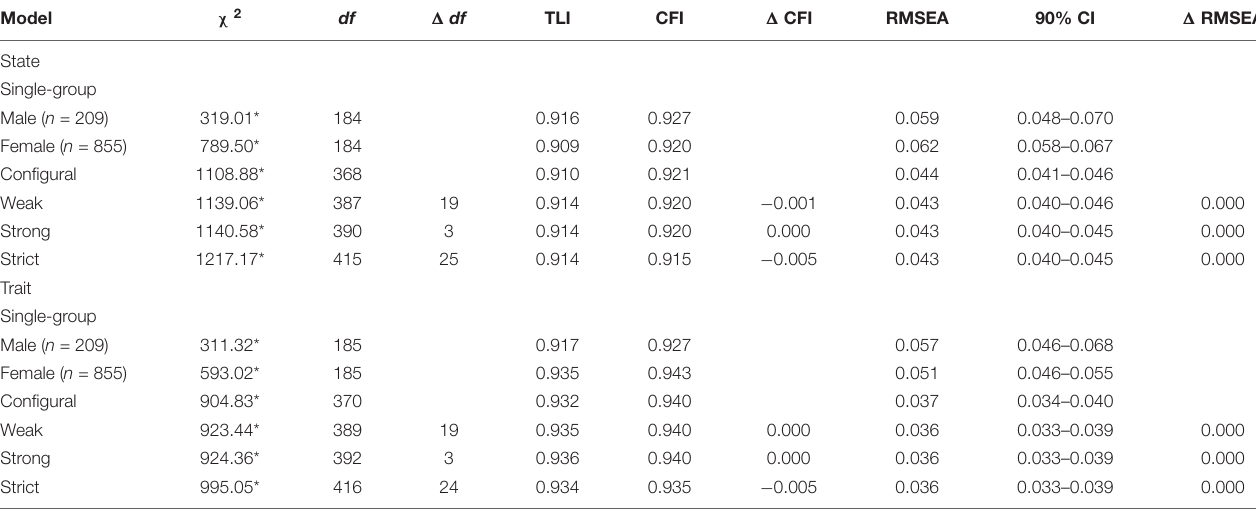
TABLE 3 | Measurement invariance across male and female samples.